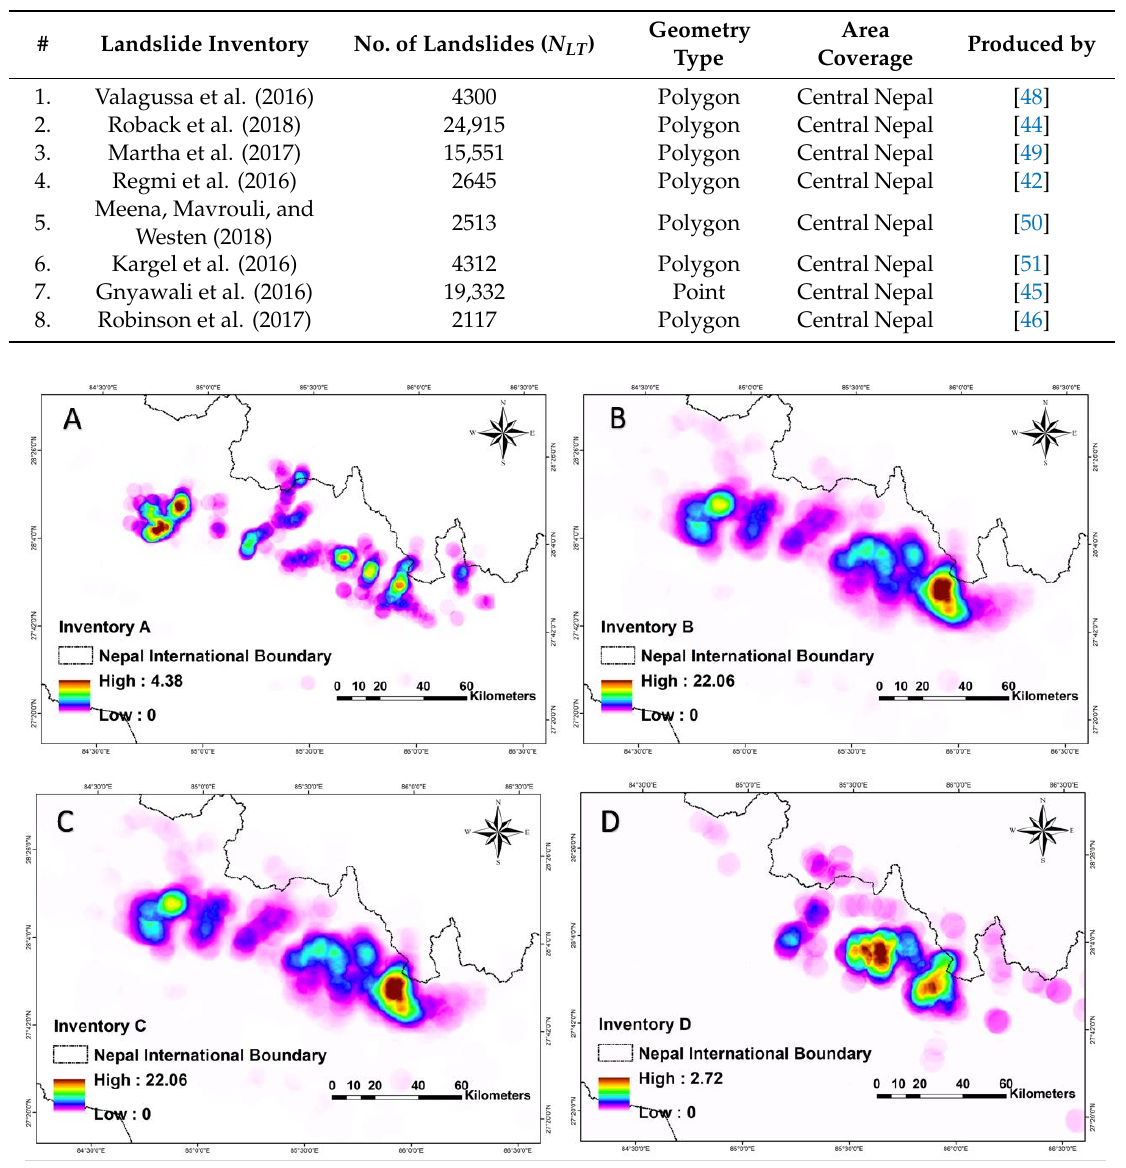
Table 1. Landslide inventories prepared after the 2015 Gorkha earthquake, Nepal.